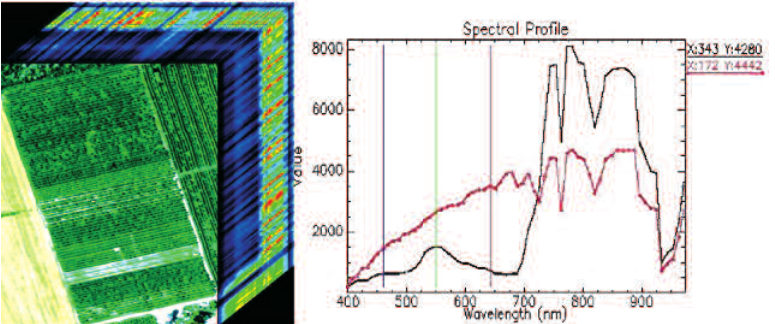
Figure 1: The 3D data cube made from 69 VIS-NIR channels and spectral reflectance curves of pixels, in Siófok